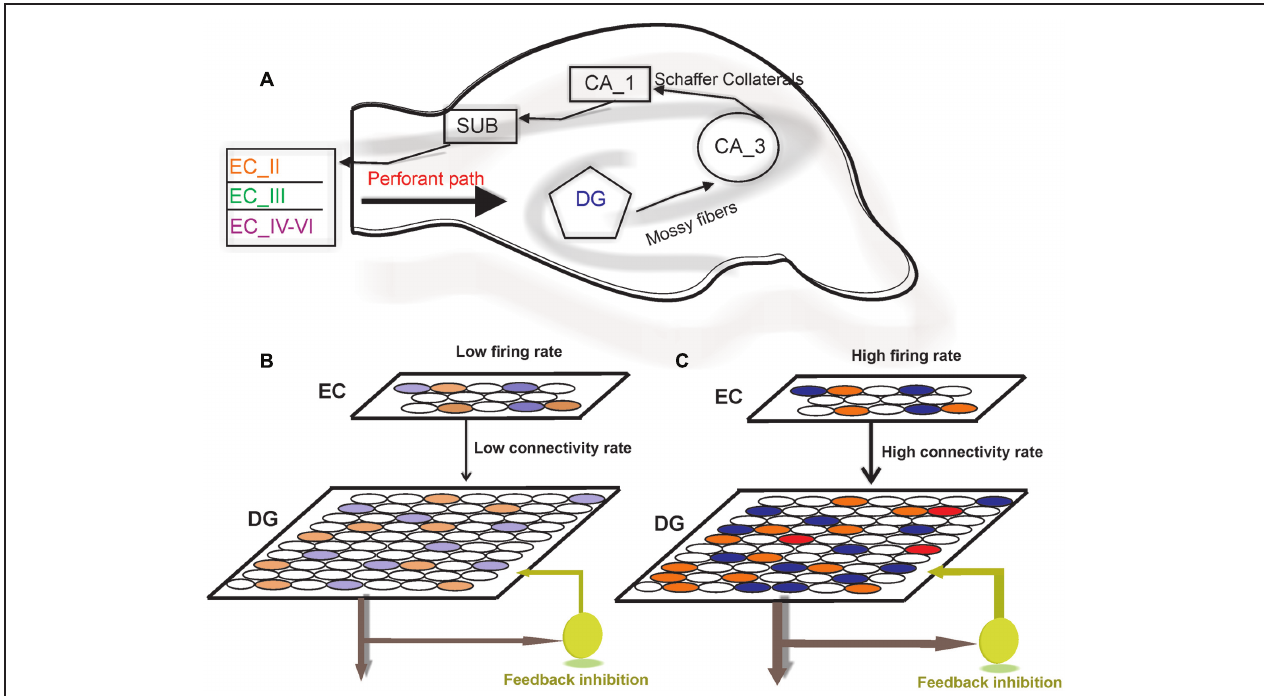
FIGURE 1 | Model structure. (A) Information flow in the hippocampus. The perforant path is the major input to the hippocampus. The axons of the perforant path mainly arise in layer II of the entorhinal cortex (ECII). Axons from ECII/IV project to the granule cells of the DG. The mossy fibers are the axons of the DG granule cells and extend from the DG to CA3 pyramidal cells, forming their major input. Information is transferred by axons that project from the CA3 to the CA1 region. The information from CA1 to the subiculum (SUB) and on the